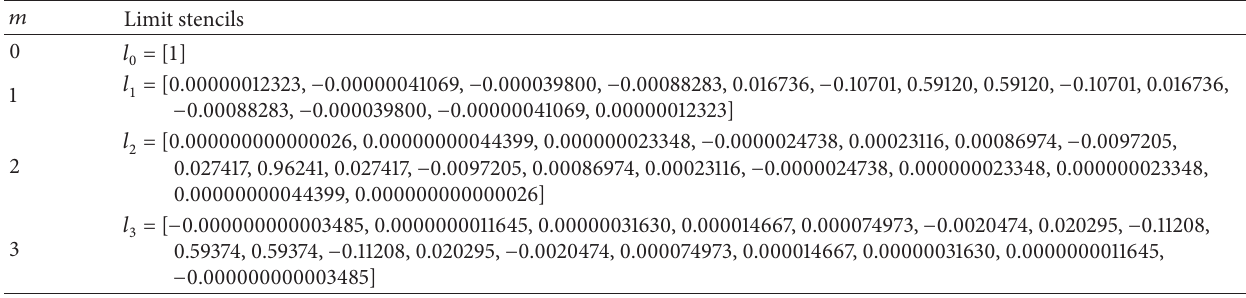
Table 3: Limit stencils of the 𝑞